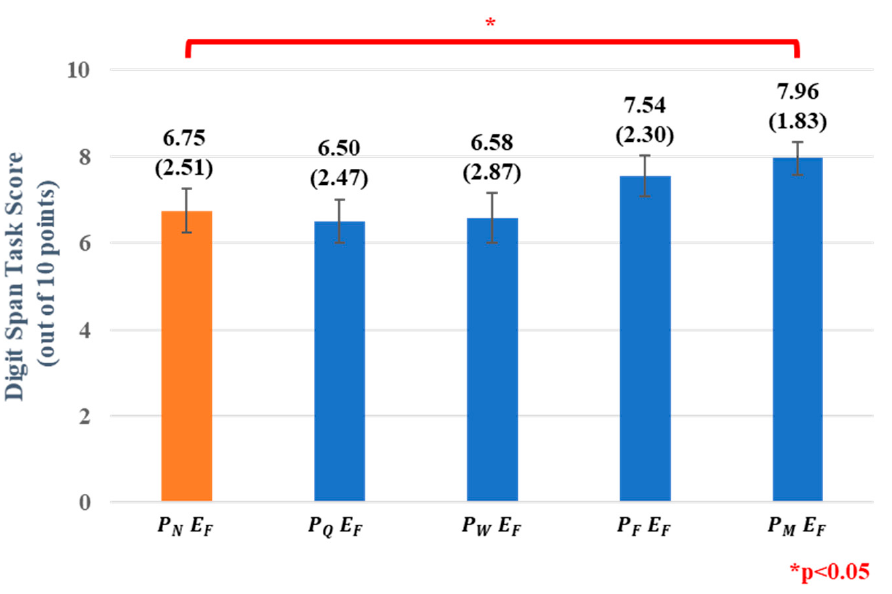
Figure 6. The mean and standard deviation of Digit span task scores for each experimental condi- tion.